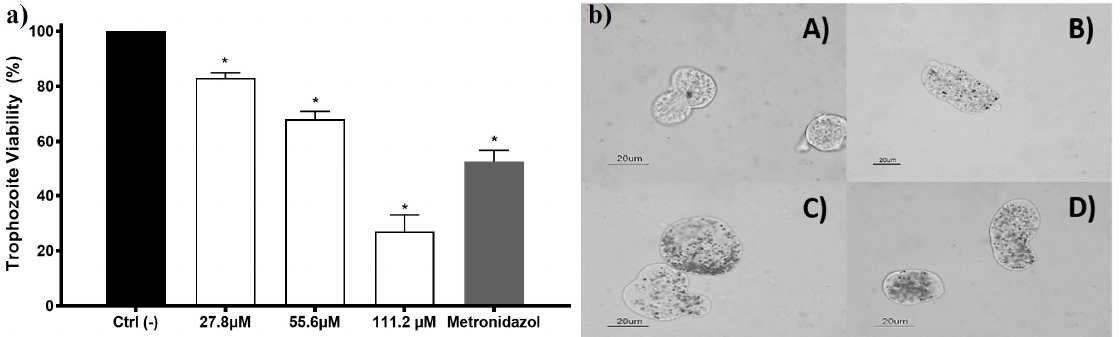
Figure 3. The amoebicidal activity of AgNPs against trophozoites of Entamoeba histolytica . E. histolytica trophozoite’s viability exposed to different concentrations of AgNPs 27.8, 55.6, and 111.2 µM of metallic silver (3, 6, and 12 µg/mL) and metronidazole (7 µM; 0.82 µg/mL) is shown in the left panel ( a ). The right panel ( b ) shows the micrographs of trophozoites ( A ) untreated and exposed to ( B ) 27.8 µM (3 µg/mL); ( C ) 55.6 µM (6 µg/mL), and ( D ) 111.2 µM (12 µg/mL) of metallic silver contained in AgNPs. The * represents a significant difference ( p ≤ 0.05) compared with the negative control.